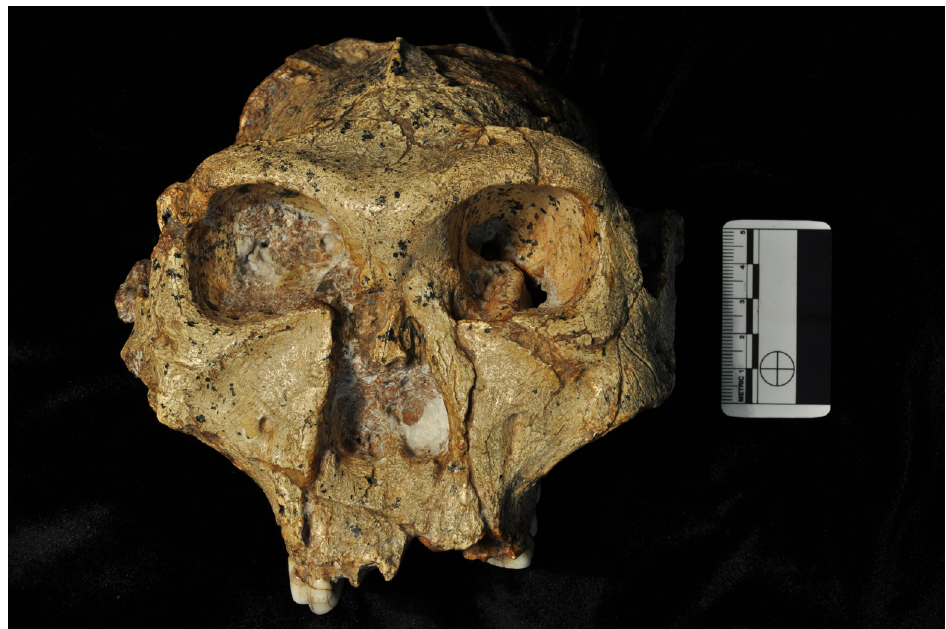
Fig. 3: Paranthropus robustus